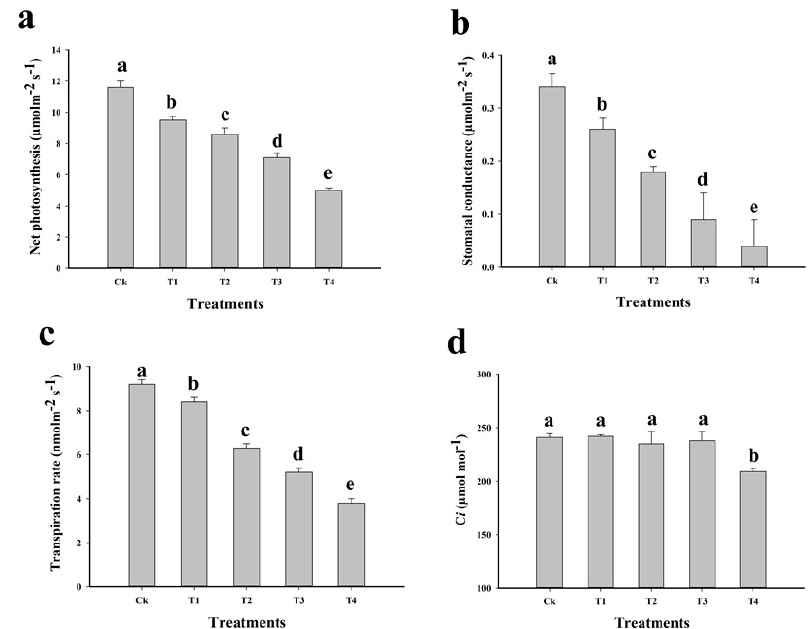
Figure 1. Effect of different levels of Cu-contaminated soil mixed with natural soil on net photosynthesis ( a ), stomatal conductance ( b ), transpiration rate ( c ) and intercellular CO 2 in the leaves of C. capsularis . Values in the figures are just one harvest. Bars sharing different lowercase letters denote significant statistical differences among the treatments at p < 0.05 according to least significant difference (LSD) test. Data shown are the average of three replications ( n = 3). Ck (soil without addition of Cu-contaminated soil), T1 (Cu-contaminated soil is mixed with natural soil by 1:4), T2 (Cu-contaminated soil is mixed with natural soil by 1:2), T3 (Cu-contaminated soil is mixed with natural soil by 1:1) and T4 (Cu-contaminated soil is mixed with natural soil by 1:0).